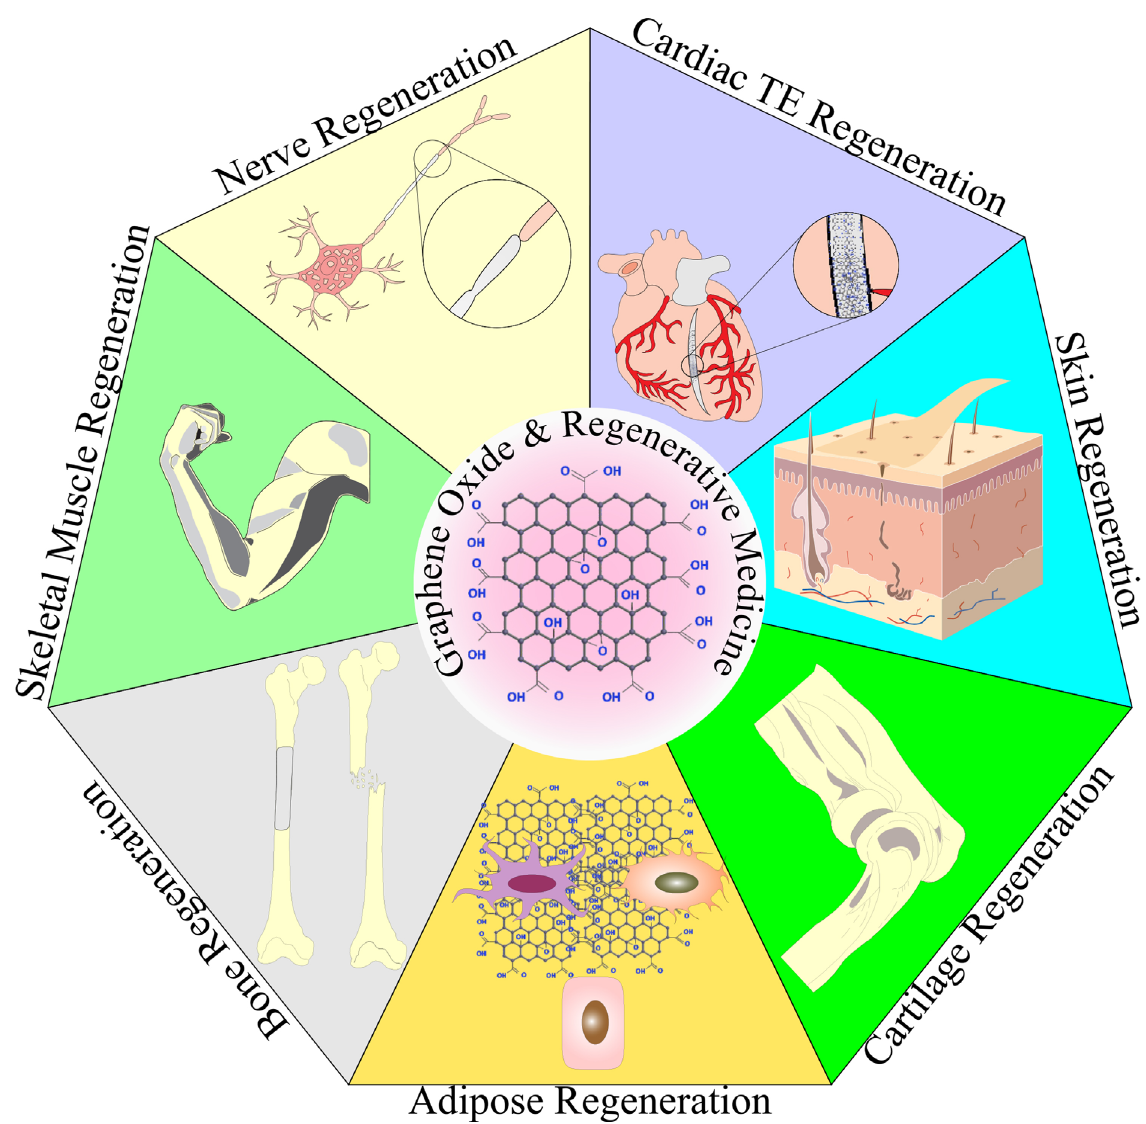
Figure 1: Applications of graphene oxide s for tissue